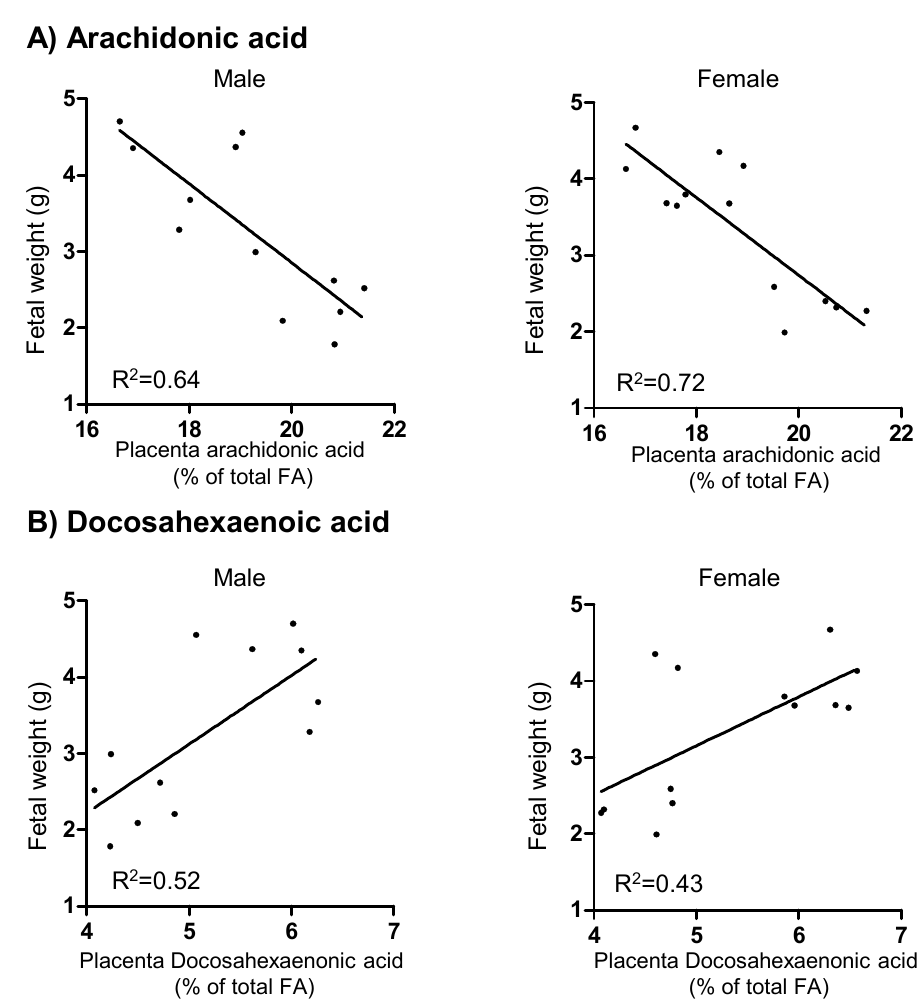
Figure 6. Correlations between male and female fetal weights and placental levels of ( A ) arachidonic acid and ( B ) docosahexaenoic acid in experimental diet fed dams. Linear regression model. Significant interaction is shown as adjusted R 2 values.